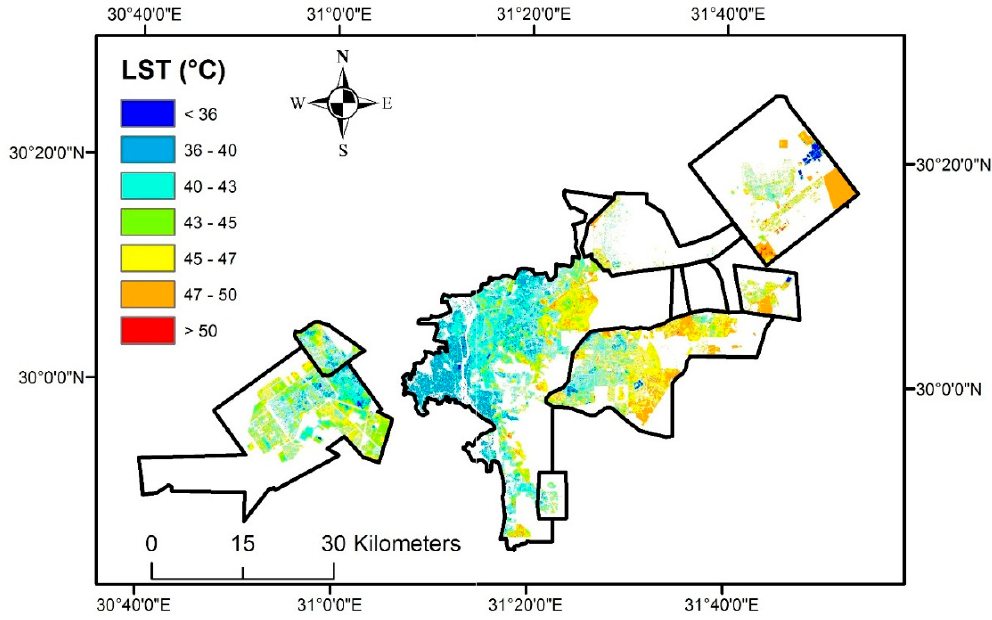
Figure 4. A sample of LST maps of built-up areas (8 August 2012, 8:18 a.m. UTC).